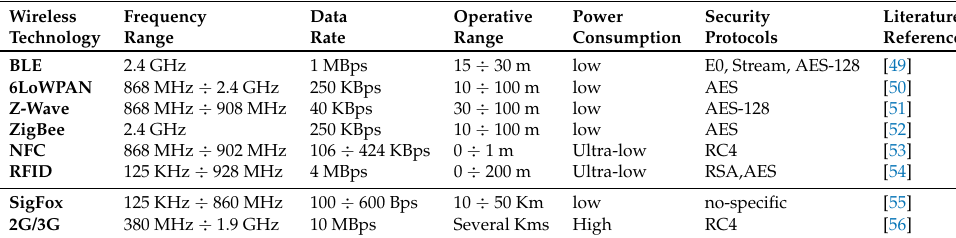
Table 1. Wireless technologies.